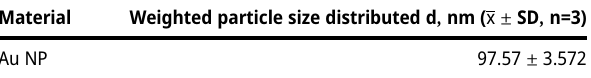
Table  : Particle size distributions of